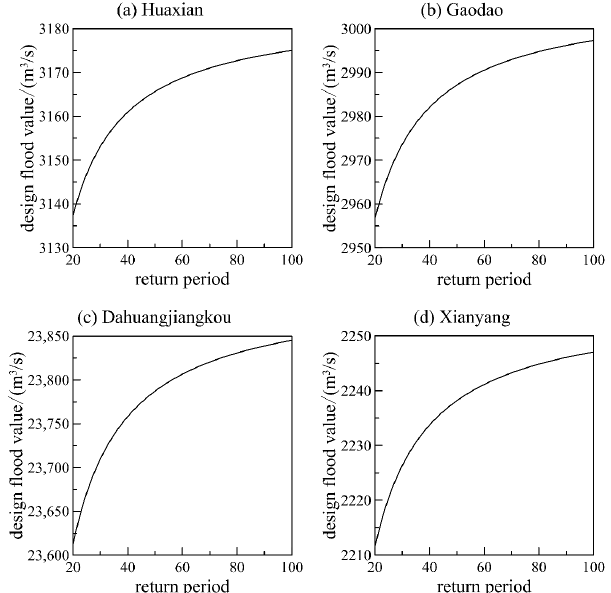
Figure 7. Flood design values estimated by average design life level (ADLL) method based on GAMLSS-CB model for ( a ) Huaxian station; ( b ) Gaodao station; ( c ) Dahuangjiangkou station; ( d ) Xianyang station.